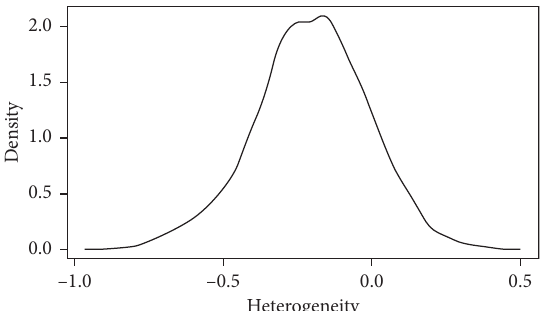
Figure 3: Differential exponential kernel density function diagram.